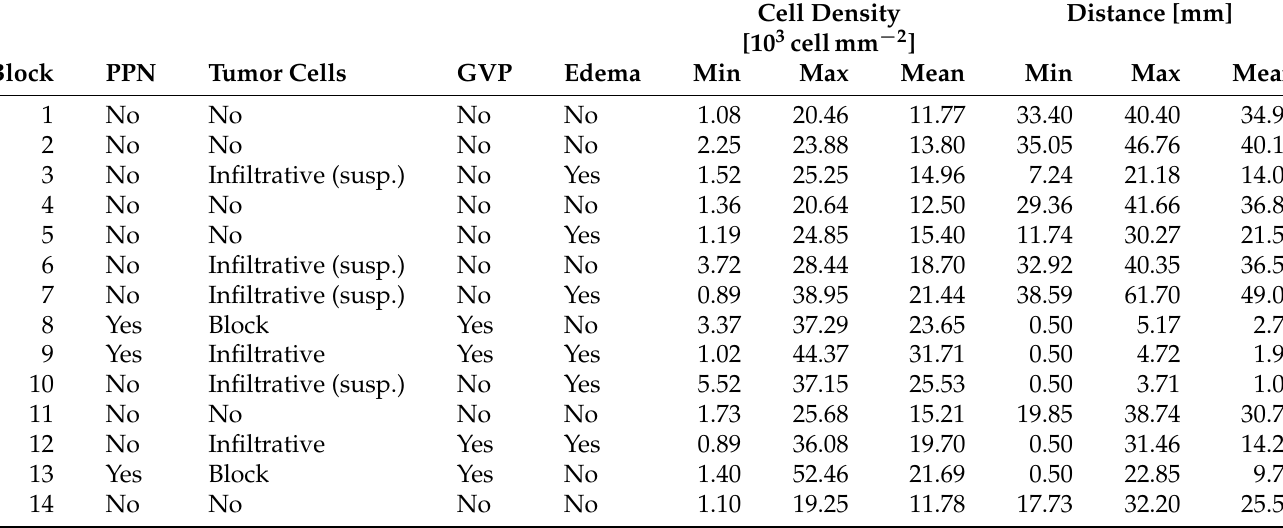
Table A1. Results of the pathological examination and numerical tile processing. PPN: pseudo-palisading necrosis, GVP: glomeruloid vascular proliferation, susp.: